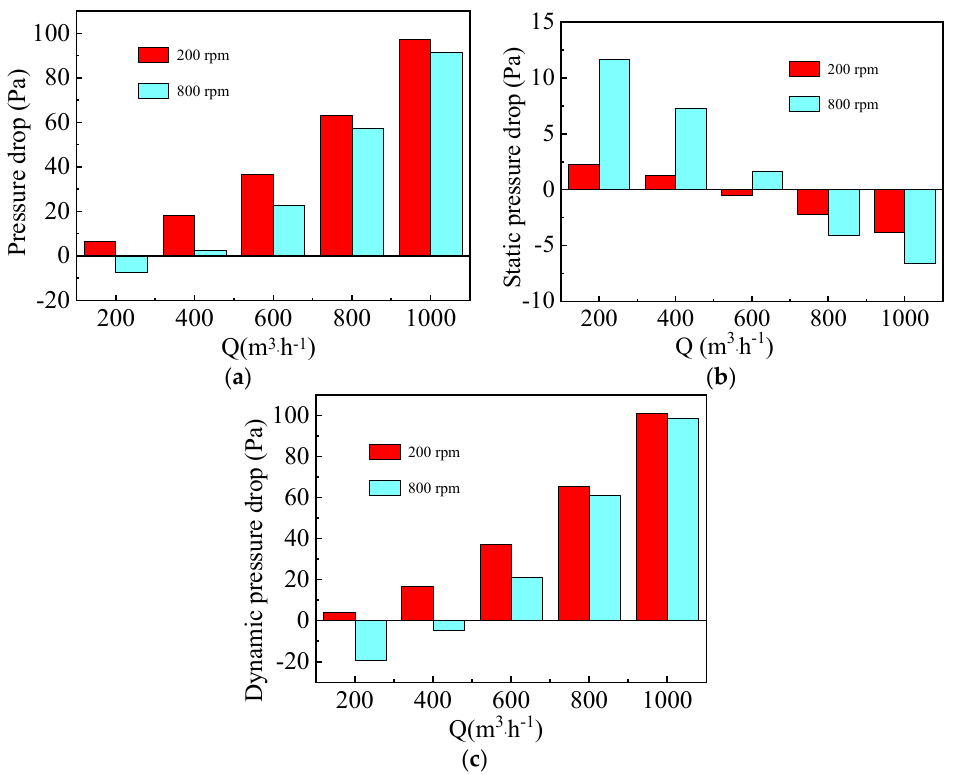
Figure 6. The effect of the gas flow rate on the pressure drop in cavity zone A. ( a ) Pressure drop; ( b ) static pressure drop; ( c ) dynamic pressure drop.